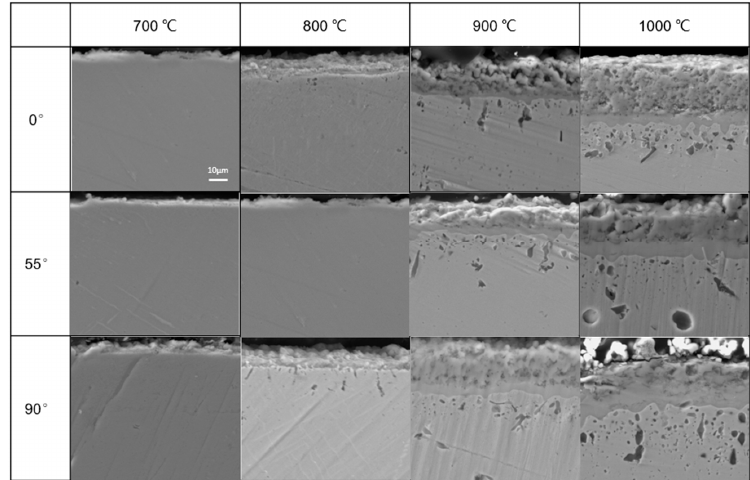
Figure 12. Cross-sectional morphology of EBM-In 718 alloys after oxidation for 100 h at different Figure 12. temperatures.